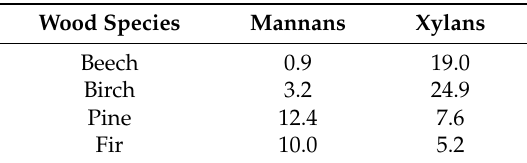
Table 6. Percentage Representation of the Major Non-glucosic Units in Hemicelluloses of Selected Wood Species (according to Fengel and Wegener [9]).